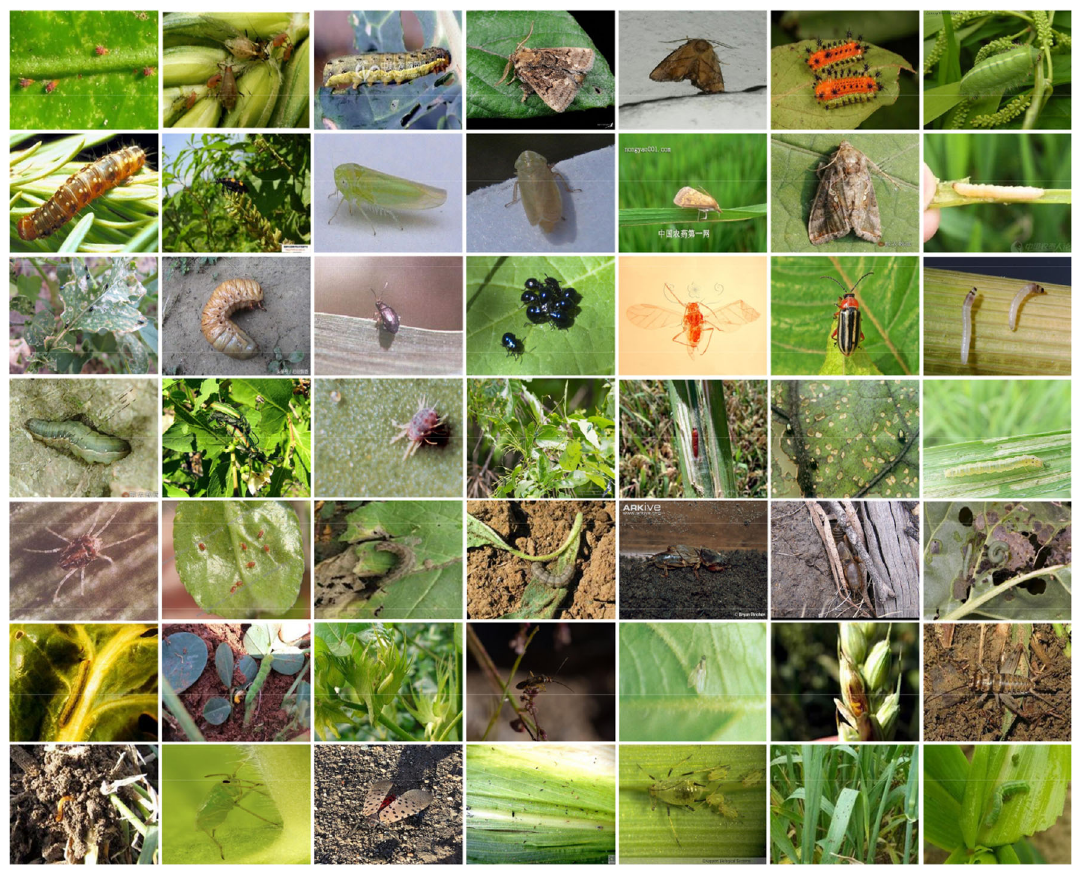
Fig. 4 Sample images from IP102 Dataset